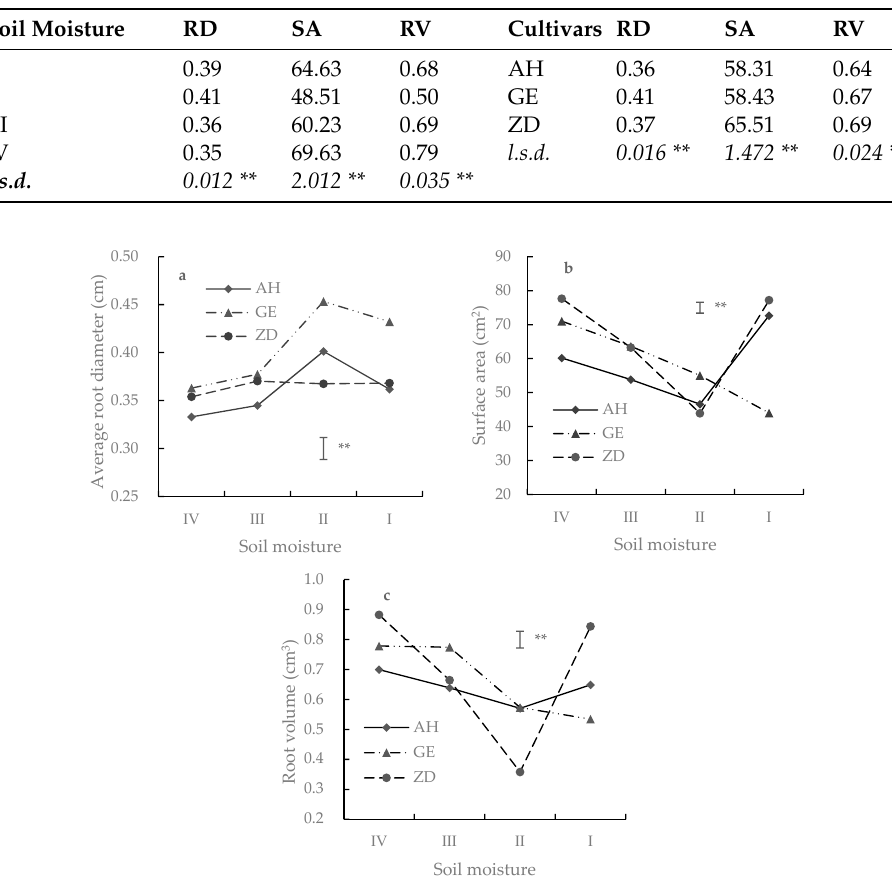
Figure 7. Interaction on ( a ) average root diameter, ( b ) root surface area and ( c ) root volume between cultivars (AH, GE and ZD) and soil moisture (See Figure 2 for soil moisture abbreviations). ** p < 0.01.